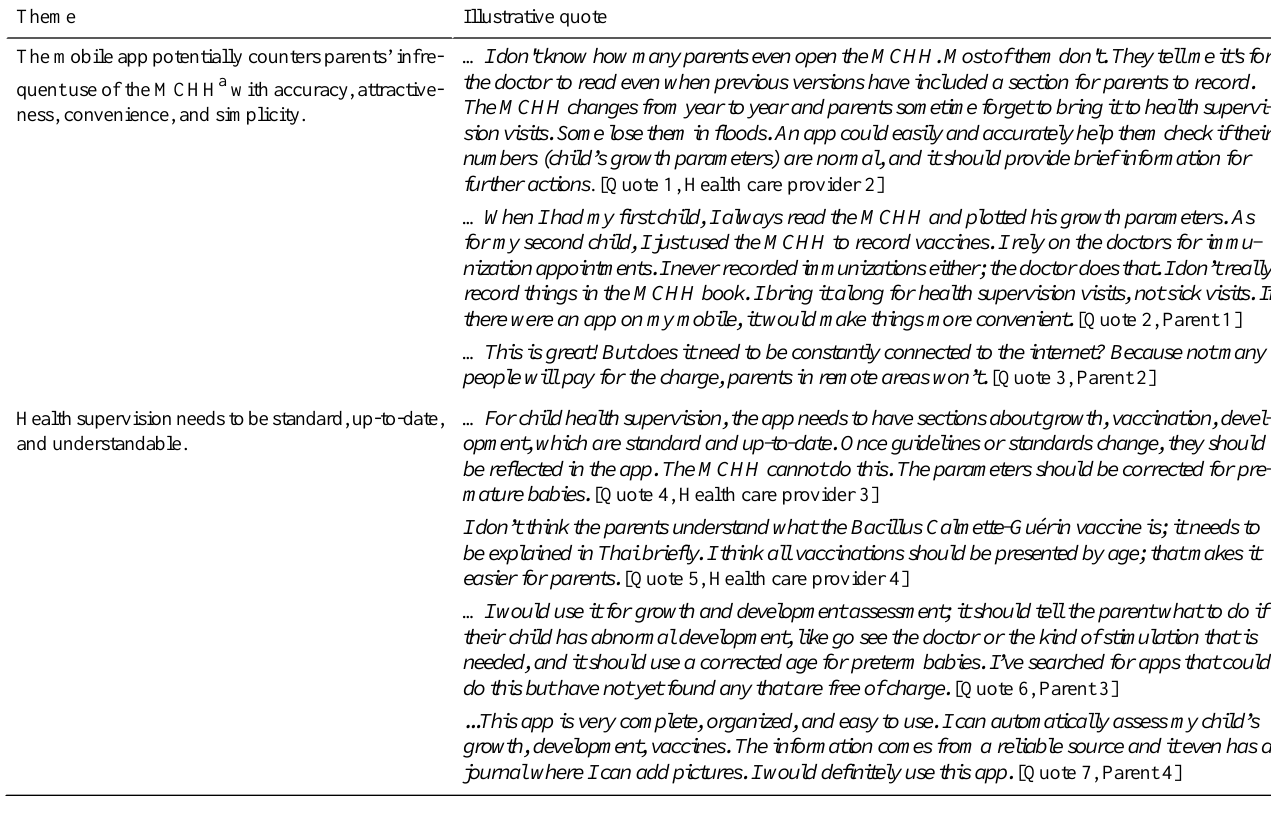
Table 1. Themes and the illustrative quotes.